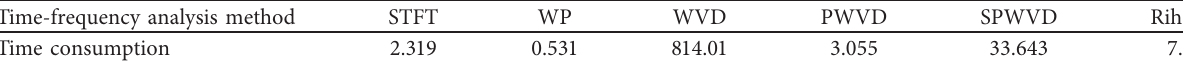
Table 5: Time consumption of different time-frequency analysis methods (unit: